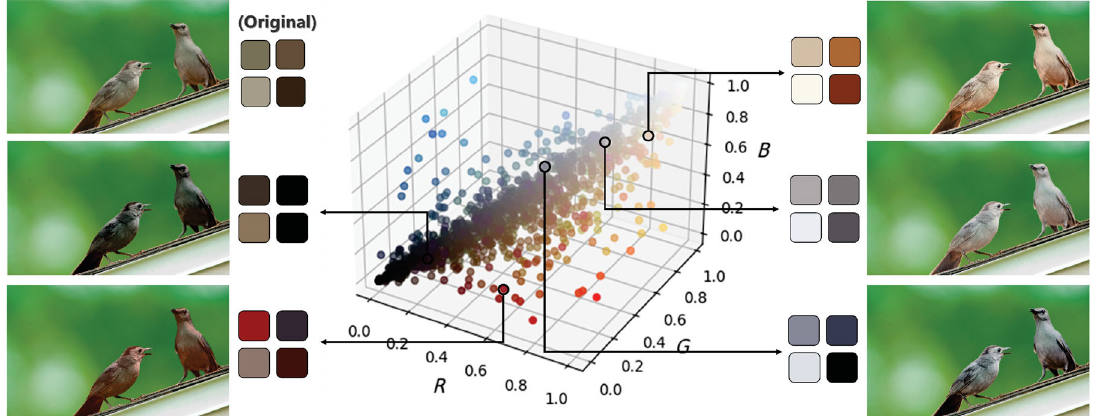
Fig. 7 Schematic diagram of our user interface. It provides a 3D diagram with color points for detected objects; a color point corresponds to a palette. When users select a point, the bird is recolored directly using the corresponding recommended palettes. We also show some recoloring results on both sides of the